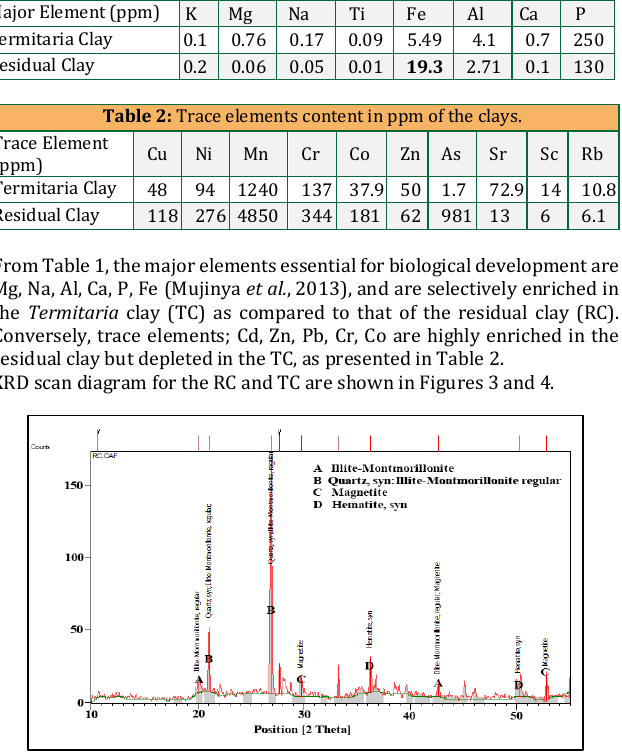
Table 1: Major elements content in ppm of the